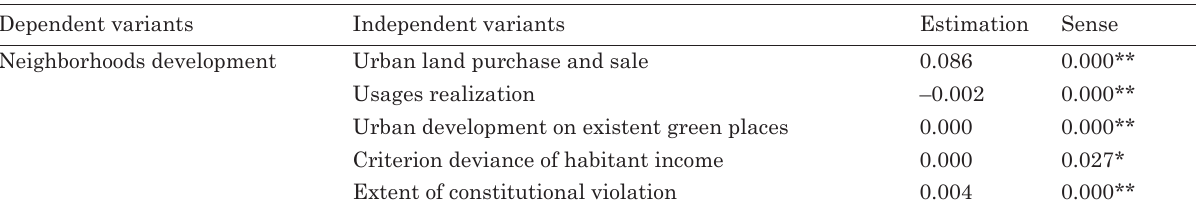
Table 10. Indicators of minor performance of structural development equations in the district three of Mashhad